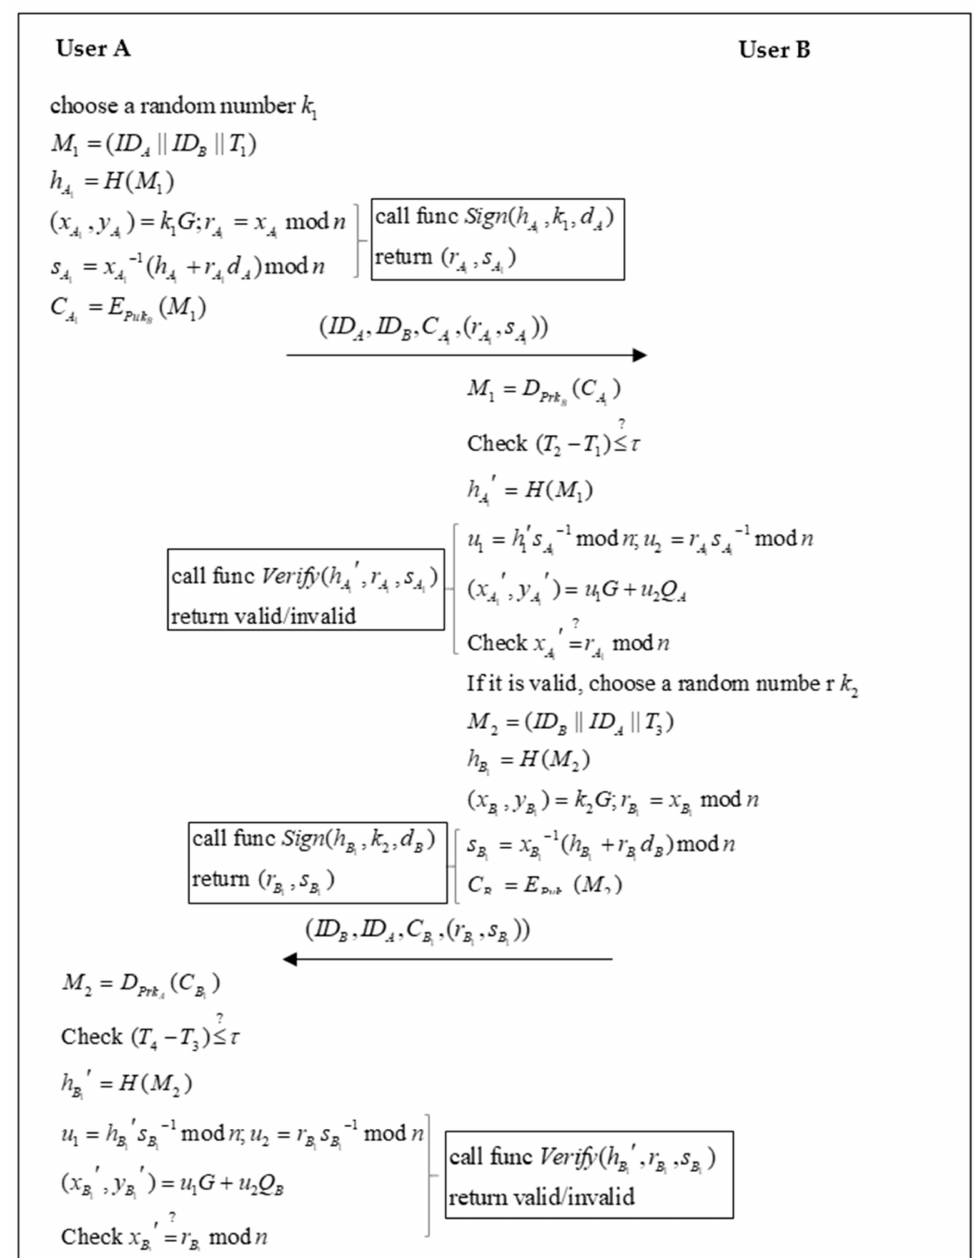
Figure 7. The flowchart of the authentication